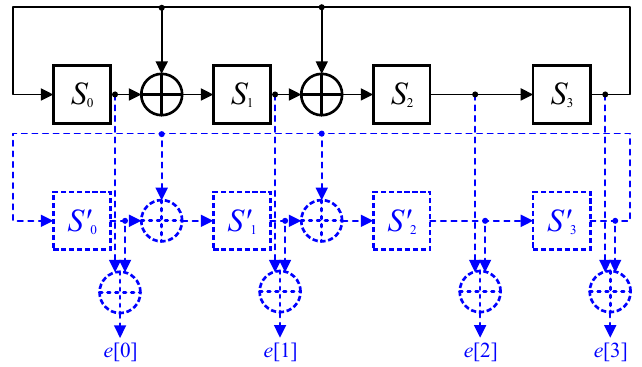
Figure 2. Example of hardware redundancy method [28–30].